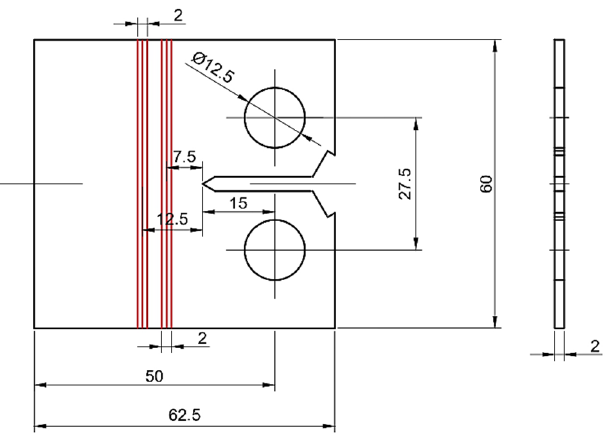
Figure 1. Geometry and dimensions (mm) of the FCG specimens, including laser lines positioning.